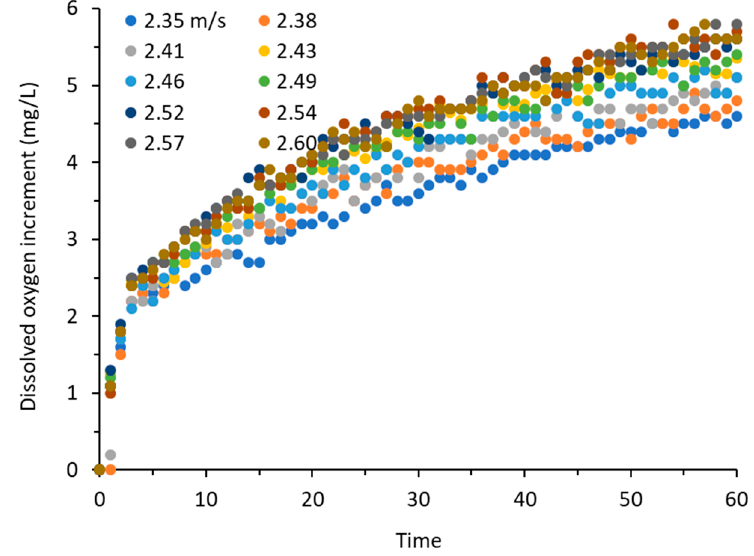
Figure 8. Dissolved oxygen (DO) increment against time at free flow of gas velocity. The DO increment is presented as relative to the initial DO reading.